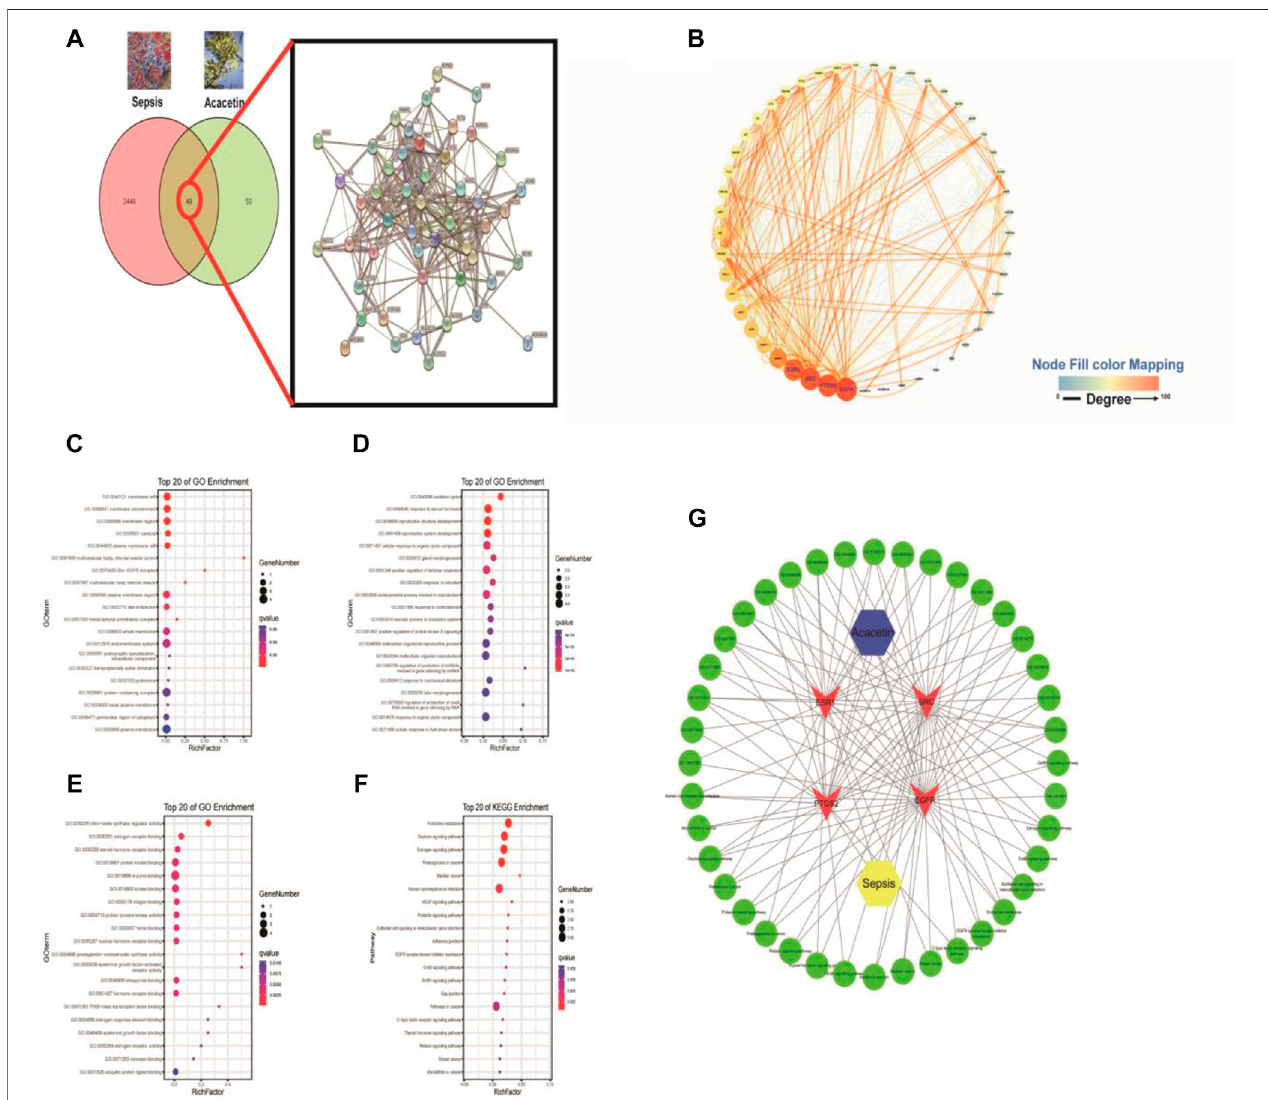
FIGURE 3 | The underlying mechanisms by which acacetin affects sepsis as determined by a network pharmacology approach. (A) All of the targets of acacetin andsepsisandthe49intersectingtargetsofacacetinandsepsiswereidenti fi ed via aVenndiagramandPPInetwork. (B) Thetopfourhubgenes/targetsofbothacacetin and sepsis were identi fi ed and arranged according to their degree value with an algorithm using Cytoscape software. (C – F) With the OmicShare service R-language packages, the four core targets were subjected to GO analyses of cellular component (CC), biological process (BP), and molecular function (MF) terms and KEGG pathwayanalysis.Thebubblediagramshowsthetop20termsrelatedtotheactivityofacacetinagainstsepsis. (G) Networkconstructedfromthebioinformaticsanalysis results highlighting the detailed interactions between acacetin-targets-GO-KEGG-sepsis. Hub targets are represented by a red V, and the top 20 BP terms and pathways involved in the activity of acacetin against sepsis are shown in